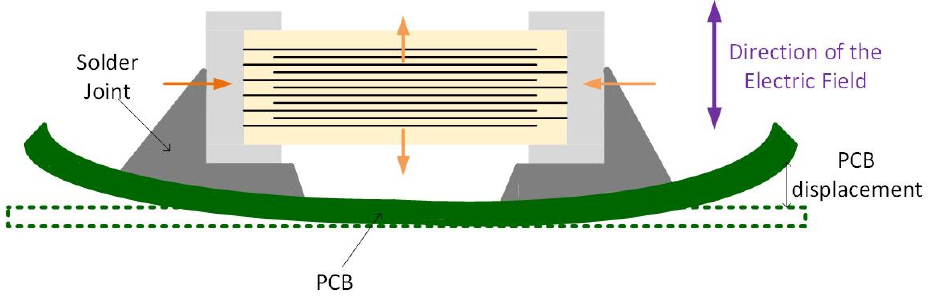
Figure 2. The mechanism for singing capacitor phenomenon.